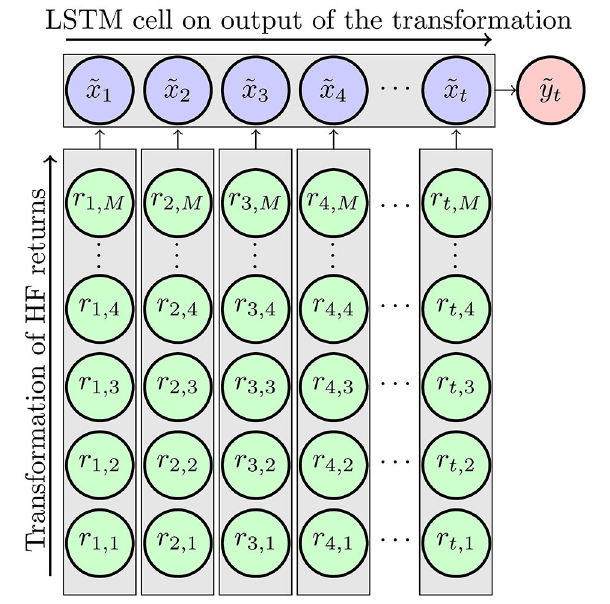
FIGURE 1 | Method depicted. The HF returns are transformed in the vertical direction, meaning that for each day 1, ... , t the same type of transformation is applied to the HF returns of that day. The result is a sequence of τ =1, ... , t x τ to which an LSTM cell is horizontally transformed measures ˜